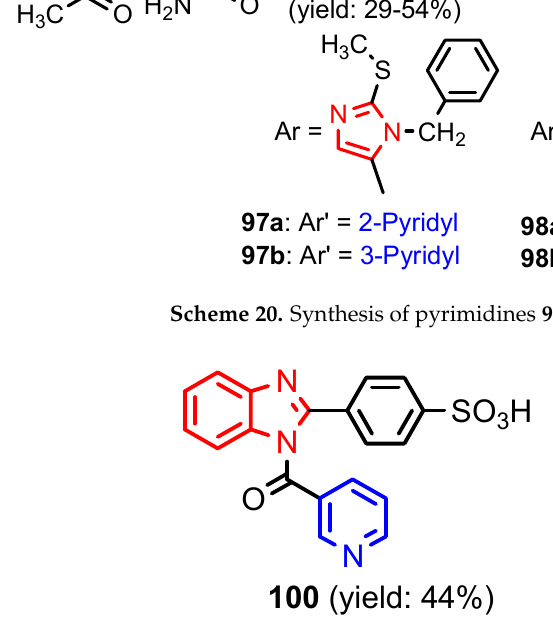
Figure 9. Structure of benzimidazole-pyridine 100 [46].